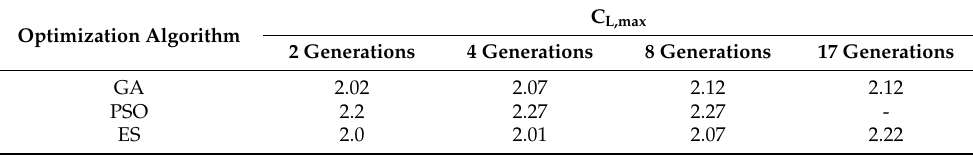
Table 1. Maximum lift coefficients of the modified airfoils created during the parametric study of the number of generations.